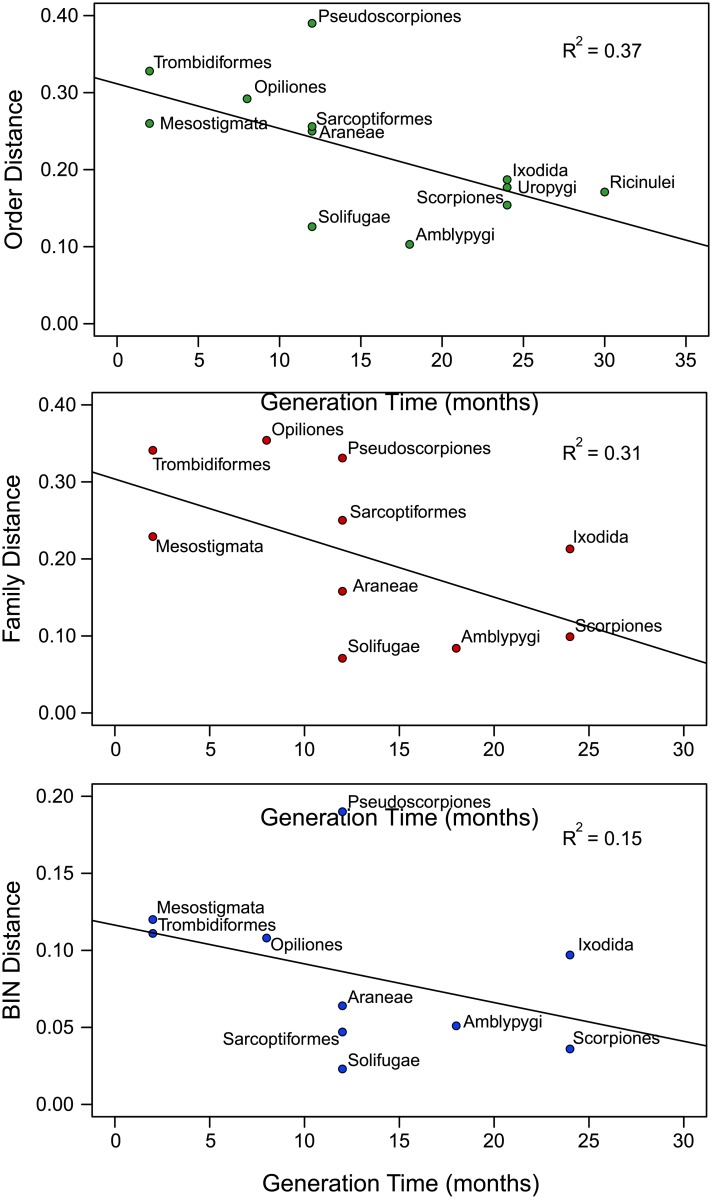
Linear regression of the relationship between generation time and average Dayhoff distances at three taxonomic levels, Order, Family, and BIN.